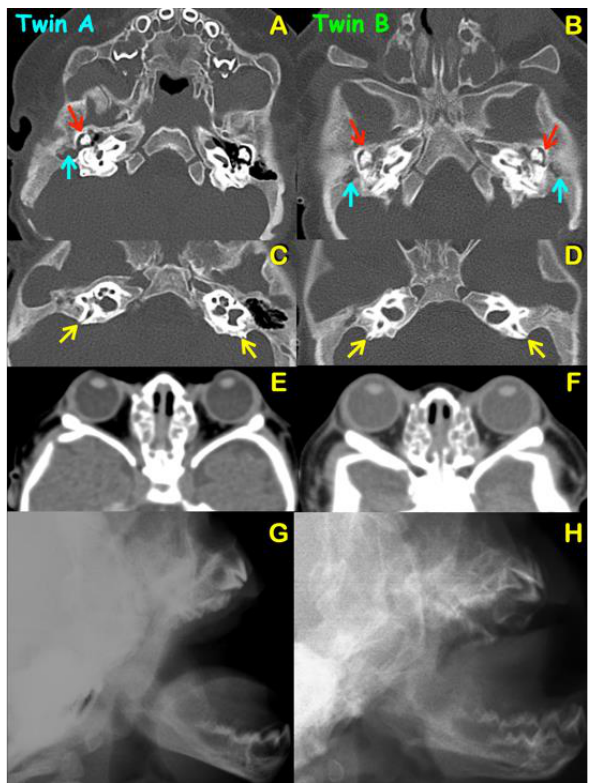
Figure 3. Radiographs and 3D CT reconstruction of twins A (A,C) and B (B,D). ( A ) Coronal synostosis (blue arrows) of twin A. ( B ) Coronal synostosis (red arrows) of twin B. ( C ) Note the cra- niolacunia of twin A. Lambdoid synostosis (blue arrow) and ipsilateral mastoid and contralateral parietal bossing with associated downward tilt of the cranial base toward the affected side. ( D ) Cra- niolacunia and patent lambdoid suture of twin B.